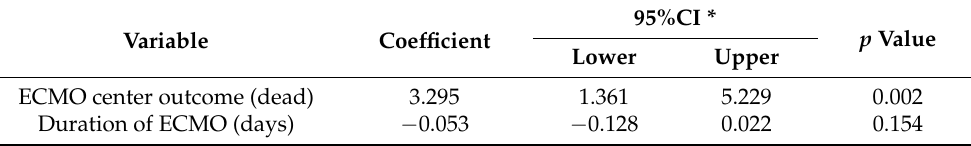
Table 6. Multiple regression analysis for OAG-F score elevation.